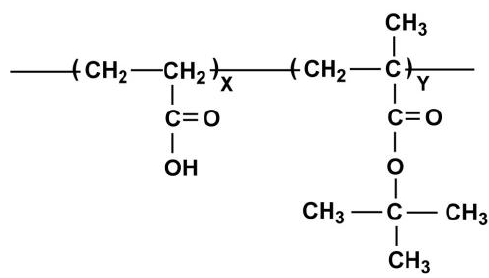
Figure 2. The chemical structure of poly(AAc- co -nBMA)